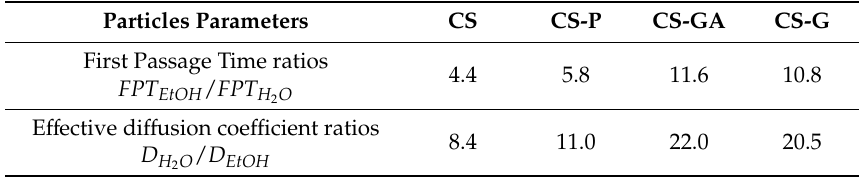
Table 2. The First Passage Time ratios and the effective diffusion coefficient ratios for alginate membranes filled with neat chitosan (CS) and modified CS microparticles; phosphorylated chitosan (CS-P), glycidol- modified chitosan (CS-G), and glutaraldehyde crosslinked chitosan (CS-GA). Particles